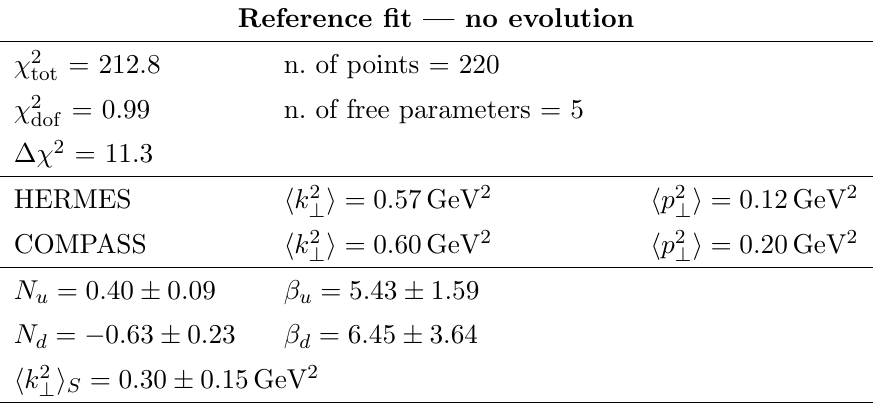
Table 2 . Best (cid:12)t parameters and (cid:31) 2 values for the reference (cid:12)t. The parameter errors correspond to 2 (cid:27) C.L. Notice that these errors are well in agreement with the uncertainties on the free parameters shown in the scatter plots of (cid:12)gure